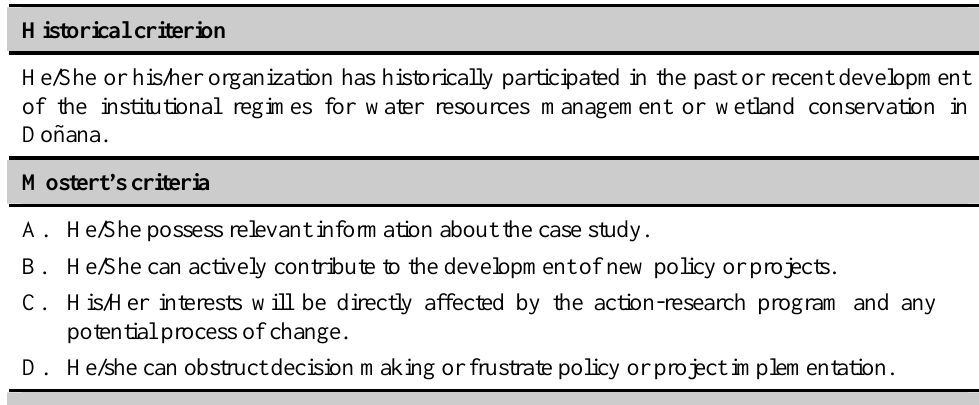
Table A2.1. Criteria used for the selection and categorization of actors in our case